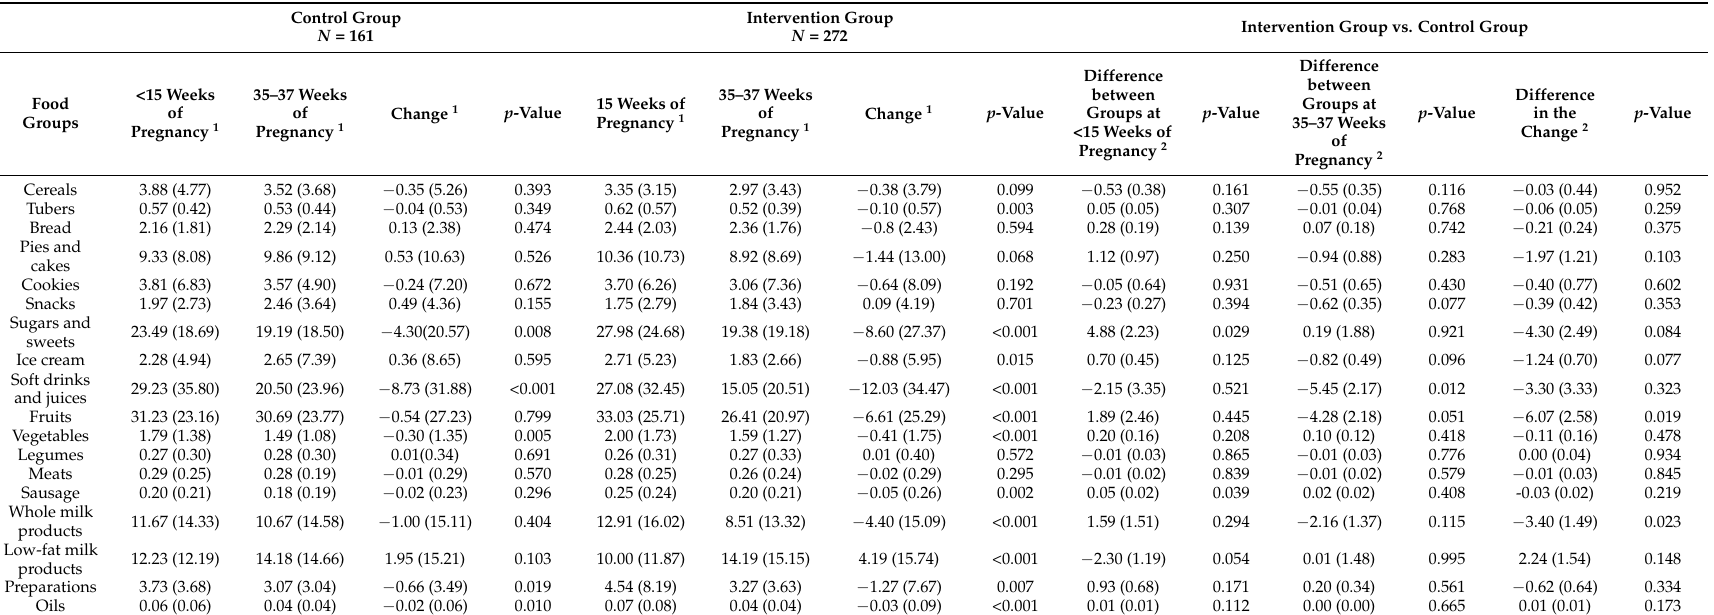
Table 3. Consumption of total sugars (g/day) by food